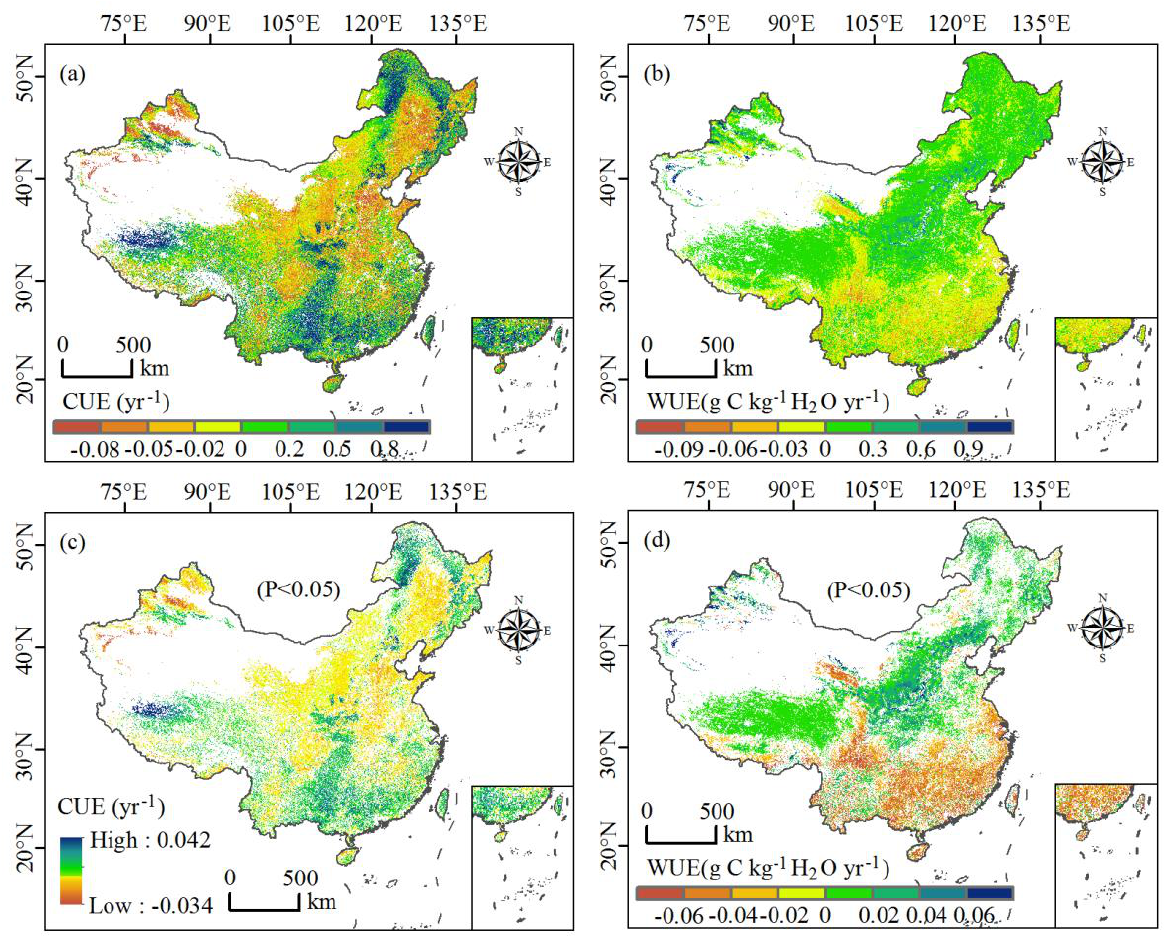
Figure 3. The g trend of CUE and WUE in China and the layers passing the significance test. ( a , b ) is the trend of CUE and WUE, ( c , d ) is the trend chart of CUE and WUE passing the significance test. Table 1. CUE and WUE trends in different areas. Qinghai – Tibet Plateau: QT; South area: SA; North area: NA; Northwest area: NW.